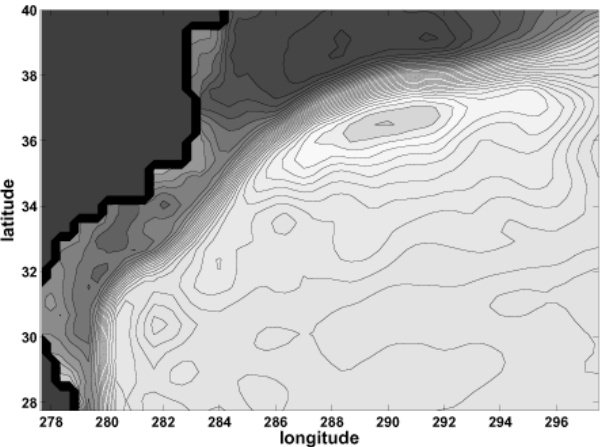
Fig. 1. Average sea-surface height, which is related to streamlines of the velocity field, in the North Atlantic. The “jet” is clearly ob- servable. Image courtesy of Jezabel Curbelo.